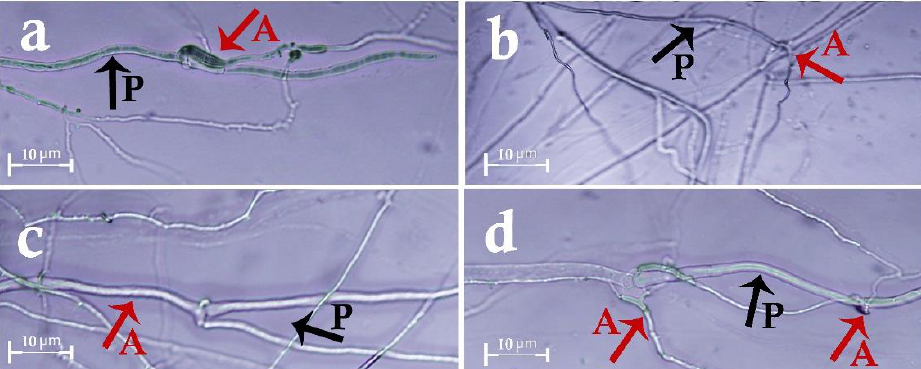
Figure 7. Hyphal coiling and hyperparasitism of the studied fungi on Sclerotium rolfsii : ( a ) Penicillium decaturense, ( b ) Aspergillus flavus , ( c ) Penicillium rubens (MN395851.1), ( d ) Penicillium rubens (MN395854.1), magnification 460×, arrows point to antagonistic fungi (A) and pathogen (P).